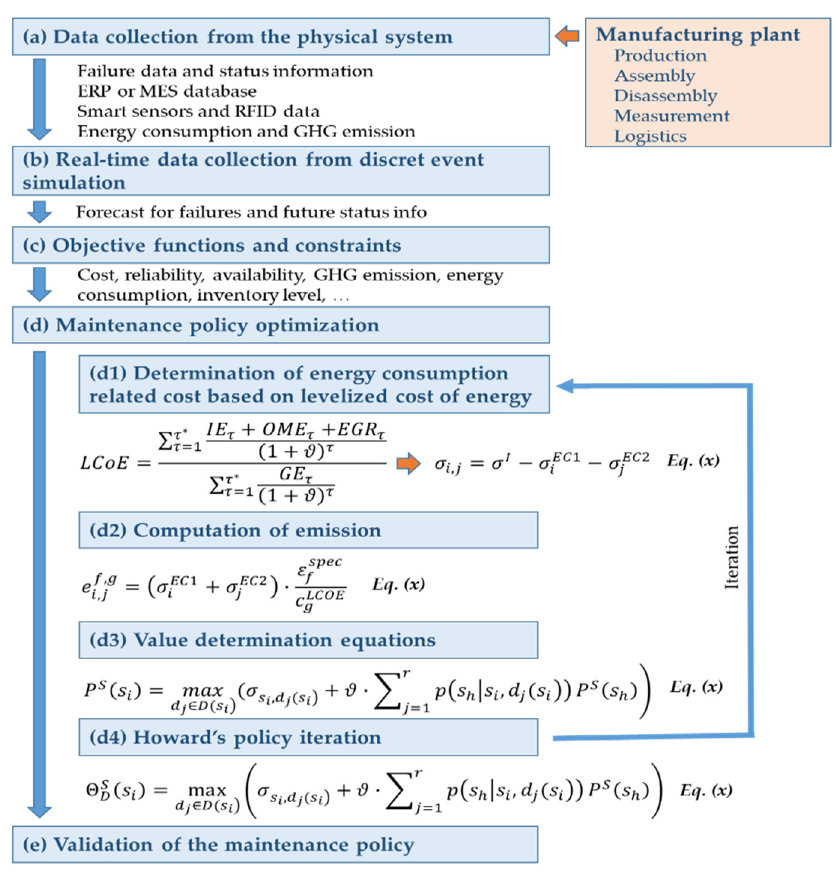
Figure 6. Multi-level maintenance policy optimization based on Howard’s policy iteration.